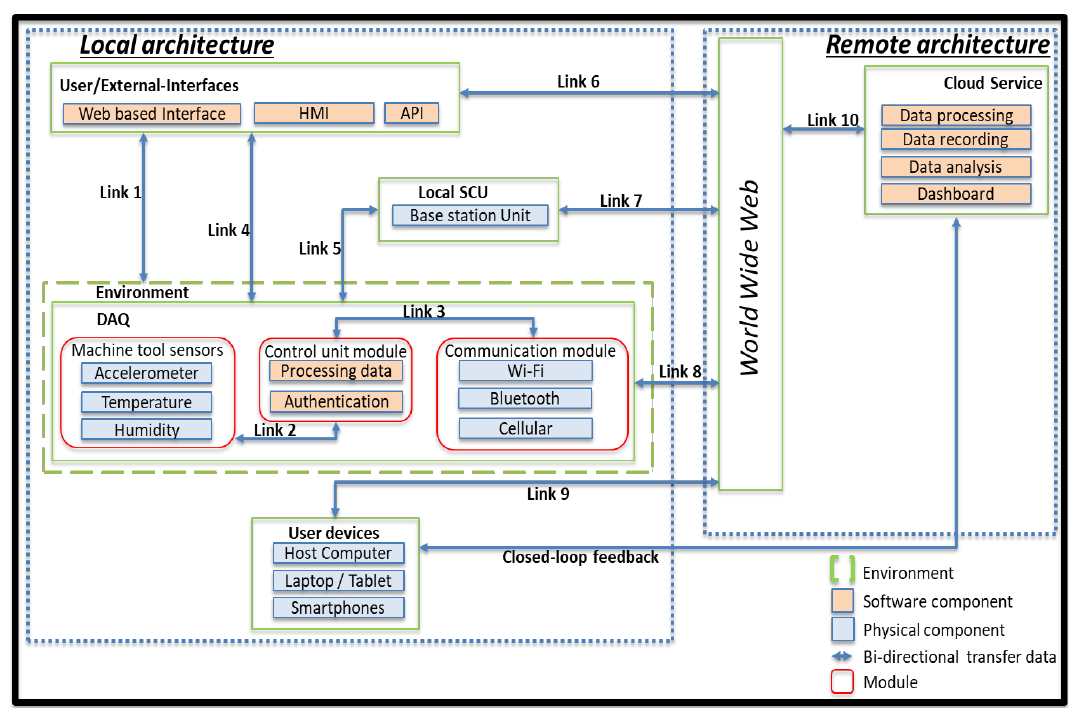
Figure 5. Abstract application model of the connected legacy production machinery. SCU: System control unit.